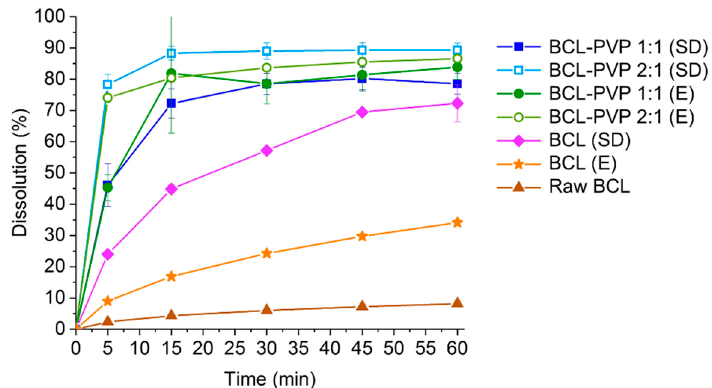
Figure 7. Dissolution of crystalline bicalutamide, drug processed alone and binary systems containing bicalutamide and PVP (1:1 and 2:1 weight ratio, respectively) obtained using evaporation technique (E) and spray drying (SD).